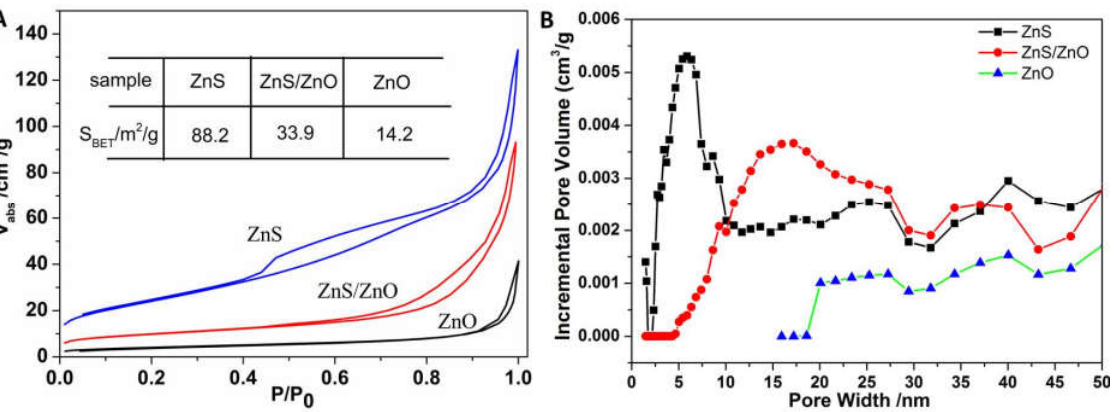
Figure 6. ( A ) BET absorption at different P/P 0 and ( B ) pore size distribution curves of ZnS, ZnS/ZnO and ZnO. ZnS/ZnO represented the sample of ZnS/ZnO-0.5 h.